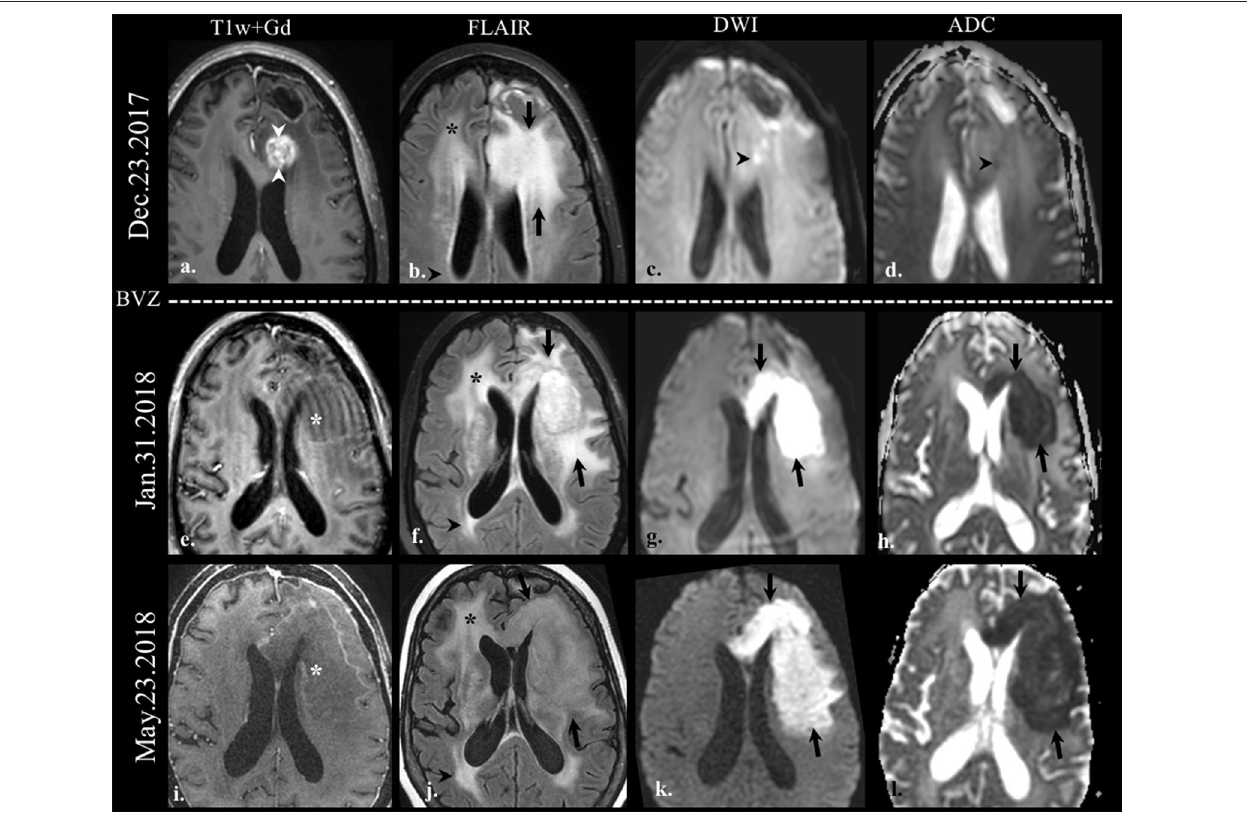
FIGURE 2 | Diffusion-weighted imaging (DWI) in pseudoresponse. Brain MRI of a old patient with the history of GBM (IDH wild-type, MGMT status unknown) on the first recurrence. Axial gadolinium-enhanced T1w (a,e,i) , FLAIR (b,f,j) , DWI (c,g,k) , and apparent diffusion coefficient map (d,h,l) images are shown. The baseline scan (top row) shows FLAIR hyperintensity (arrows on b ) involving the left frontal lobe adjacent to the posterior margin of the surgical cavity, along with an area of enhancement (arrowheads on a ). There is a small focus of DWI hyperintensity (arrowhead on c ) with its corresponding hypointensity on the ADC map (arrowhead on d ) indicative of restricted diffusion. On follow-up scans after bevacizumab treatment (BEV) the enhancement disappeared (*on e , i ); however, the FLAIR hyperintensity increased in size on the left cerebral hemisphere (arrows on b,f,j ). Note the striking increase in the size of the area of restricted diffusion on follow-up scans (arrows on g , k , h , l ) despite the absence of enhancement; this finding is indicative of the hypercellular nature of the tumor. There is non-specific progressive FLAIR hyperintensity on the right frontal lobe (*on b,f,j ), and on the right periatrial region (arrowheads on b,f,j ), without associated enhancement or restricted diffusion, likely